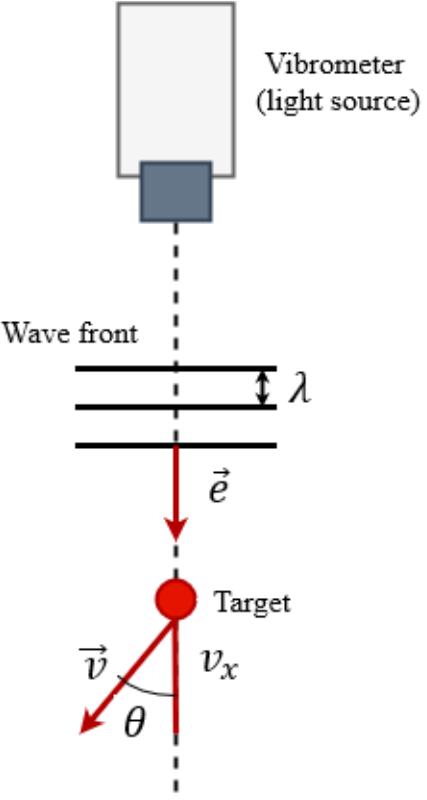
Figure 3. Vibrometer directionality and working principle scheme.